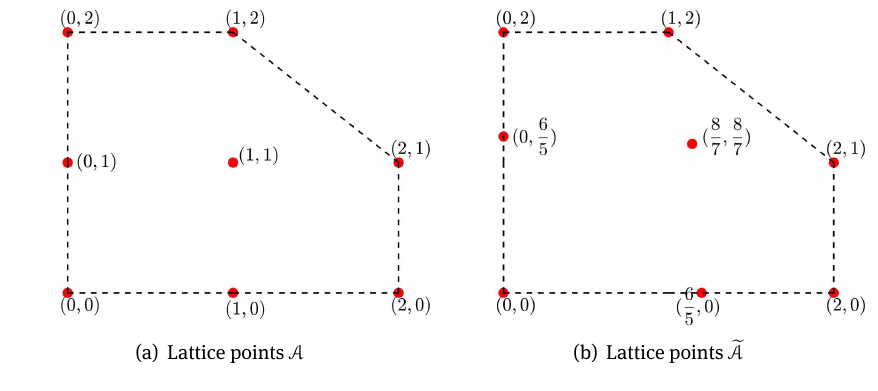
Figure 1: Lattice points A and (cid:101) A